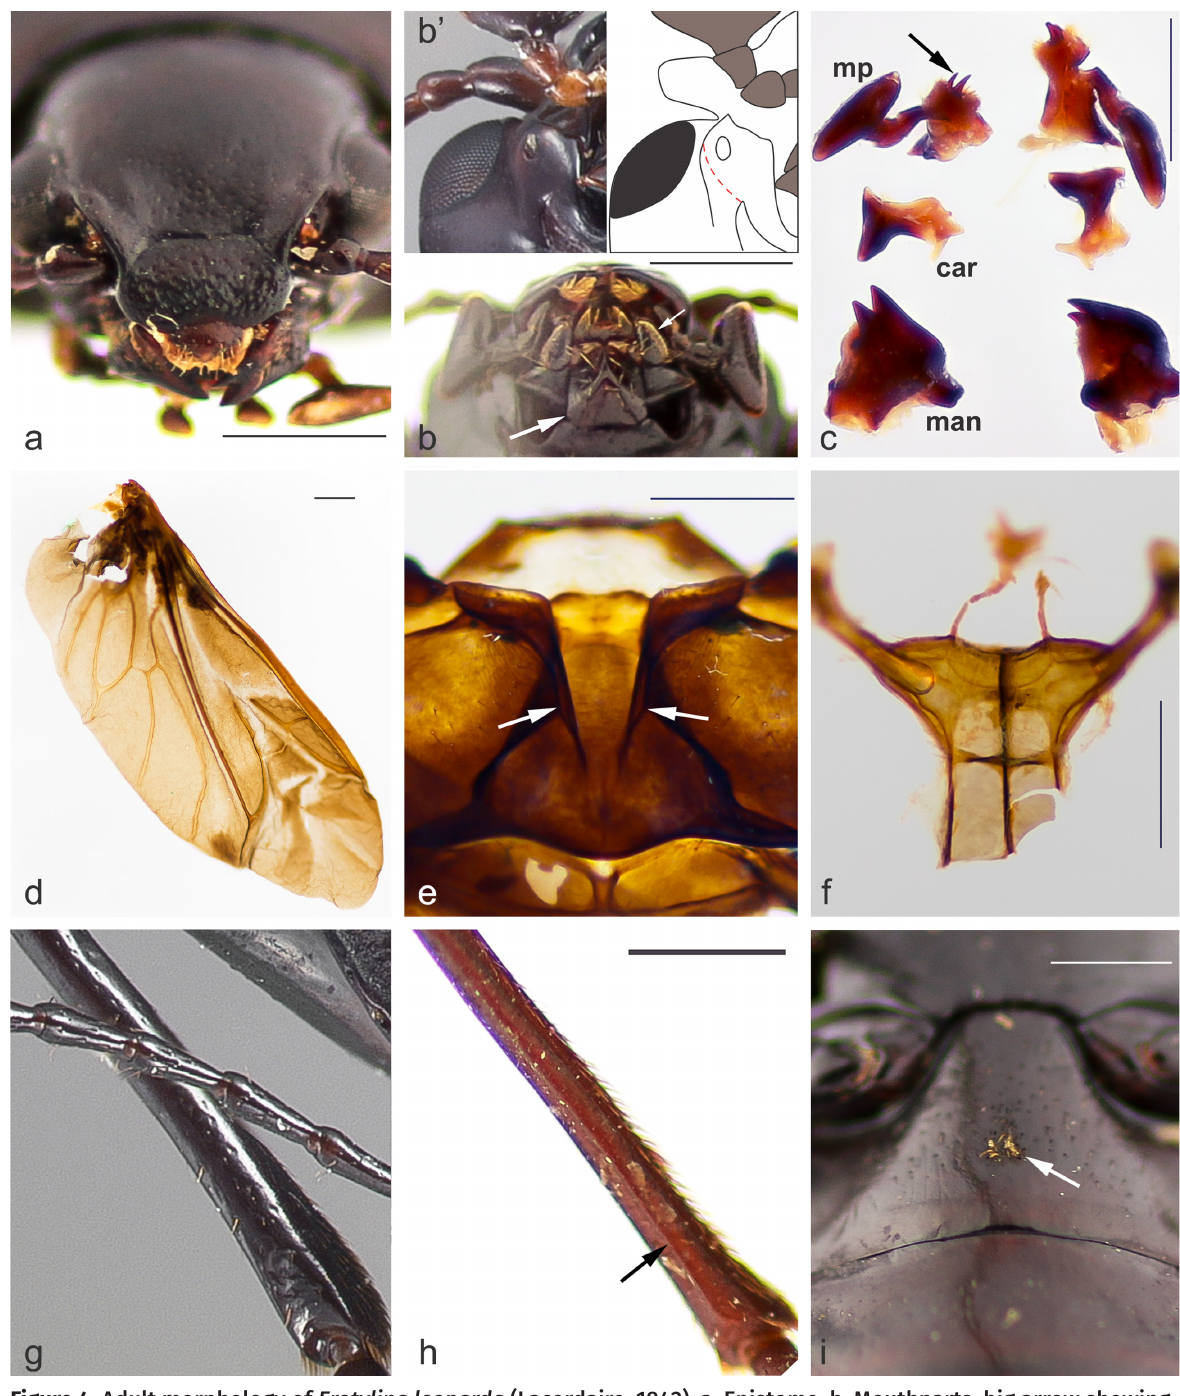
Figure 4. Adult morphology of Erotylina leoparda (Lacordaire, 1842). a. Epistome. b. Mouthparts, big arrow showing mentum plate, small arrow the labial palp. b’. Diagram showing subgenal braces, black outer contour “diverging” from red dashed line. c. Mandibles (man), cardo (car), apical maxillary palpomere (mp), arrow showing pair of hooks on lacinia. d. Metathoracic wings. e. Metanotum, arrows showing outer margin of metascutellum not touching posterior margin of metascutum. f. Metendosternite. g. Protibia lacking longitudinal carinae. h. Mesotibia of Erotylus giganteus (Linnaeus, 1758), arrow showing medial carina. i. Abdominal ventrite I of a male E. leoparda specimen, arrow showing a patch of setae. Scale bars: a–f, h–i = 1